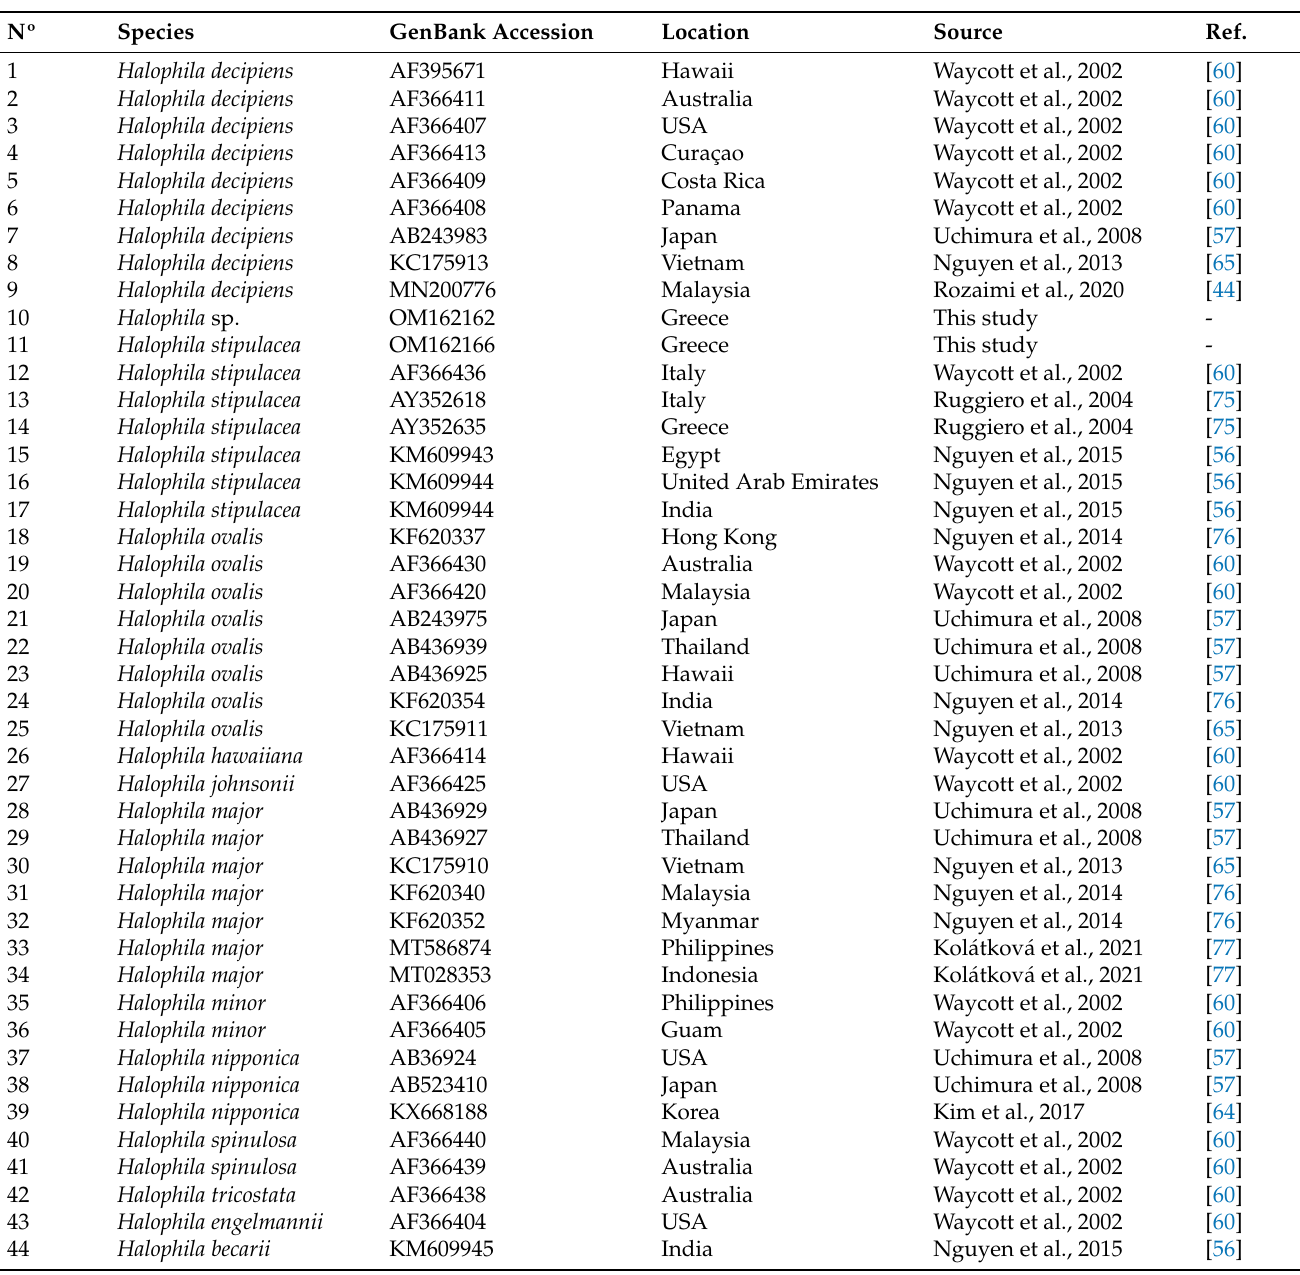
Table 1. GenBank accession numbers of the sequences included in the present ITS phylogenetic